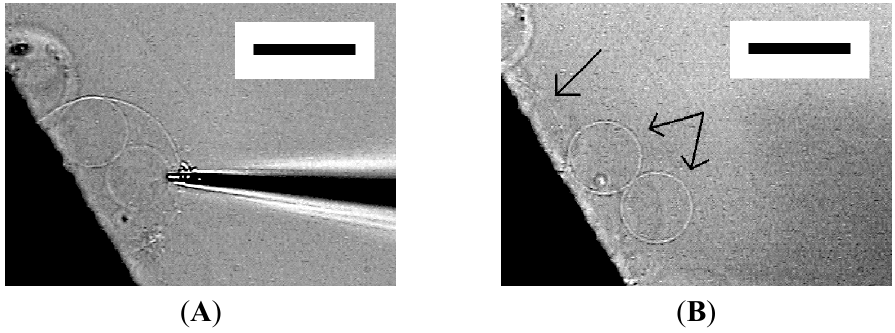
Figure 5. Release of inner GVs upon breaking the outer membrane of a semi-sphere after microvesiculation. Images are a parent semi-sphere with two GVs inside ( A ), and after breaking the outer membrane ( B ). The single arrow indicates the remnant of the broken membrane. Bar = 50 μ